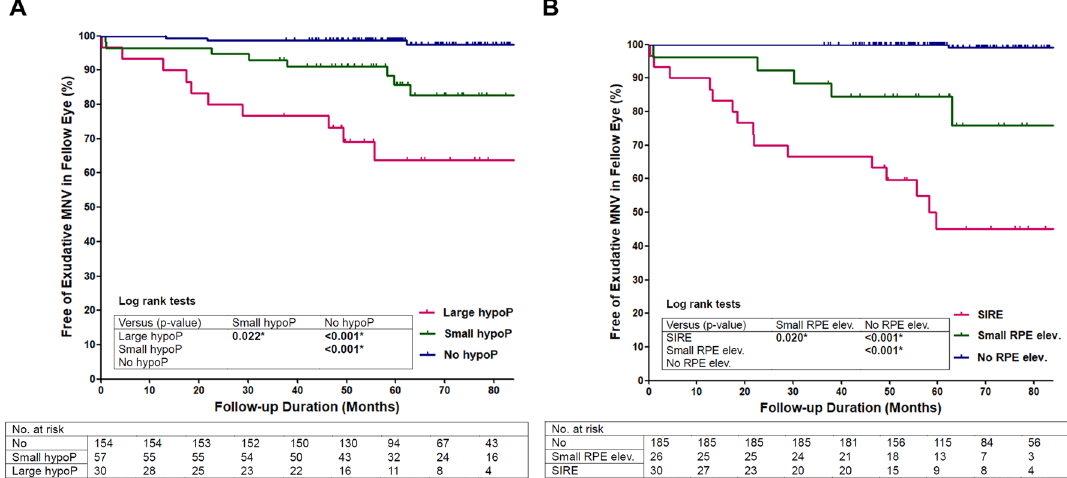
Figure 2. Time to development of exudative macular neovascularization (MNV) in the fellow eye without significant drusen and geographic atrophy in unilateral exudative MNV patients according to ( A ) Presence and size of hypopigmentation on color fundus photography (CFP), ( B ) Presence and size of RPE elevation on optical coherence tomography (OCT). The timepoint “0” is the timepoint at which MNV in the first eye has been diagnosed for the first time. The occurrence of exudative MNV in the fellow eye was used as an endpoint. The differences in survival between subgroups were displayed as P value by log-rank tests. HypoP, Hypopigmentation; SIRE, shallow irregular RPE elevation; elev.,